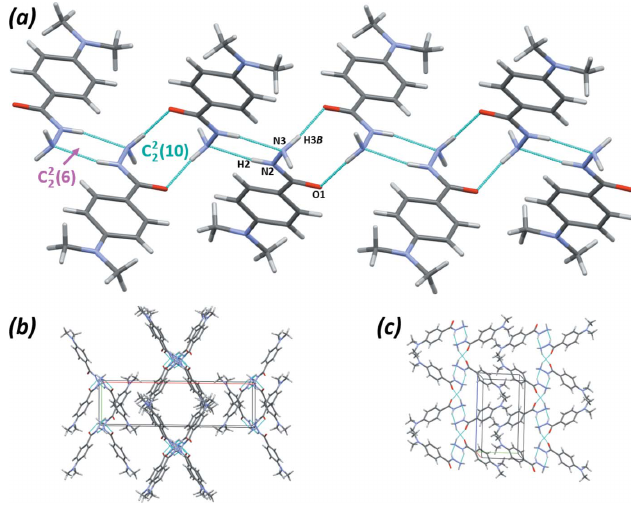
Figure 2 Molecular packing and hydrogen bonding in ( I ). ( a ) Hydrogen-bonding motifs; ( b ) and ( c ) molecular packing views down [001] and [100], respectively. Hydrogen bonds are shown as cyan dotted lines.